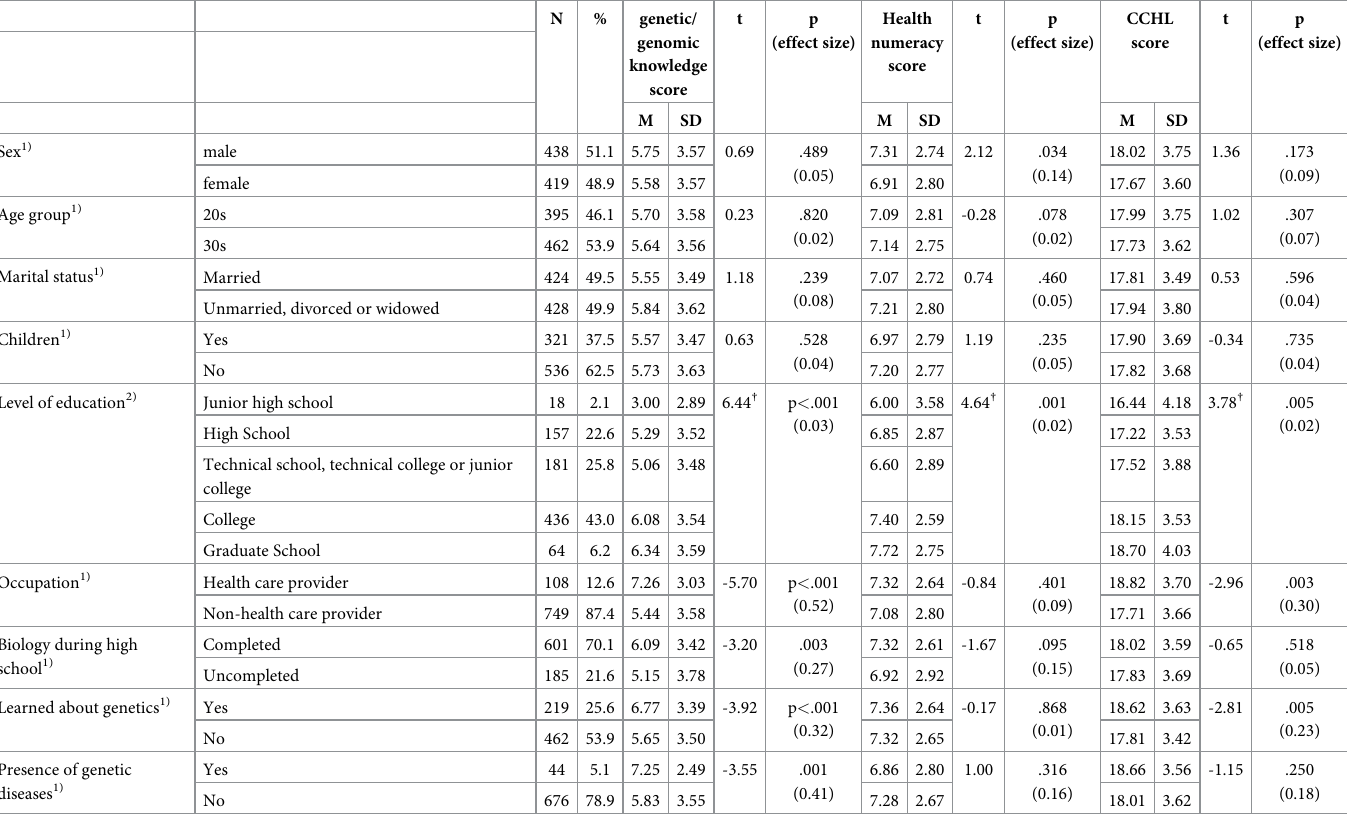
Table 1. Comparison of components of genomic literacy by